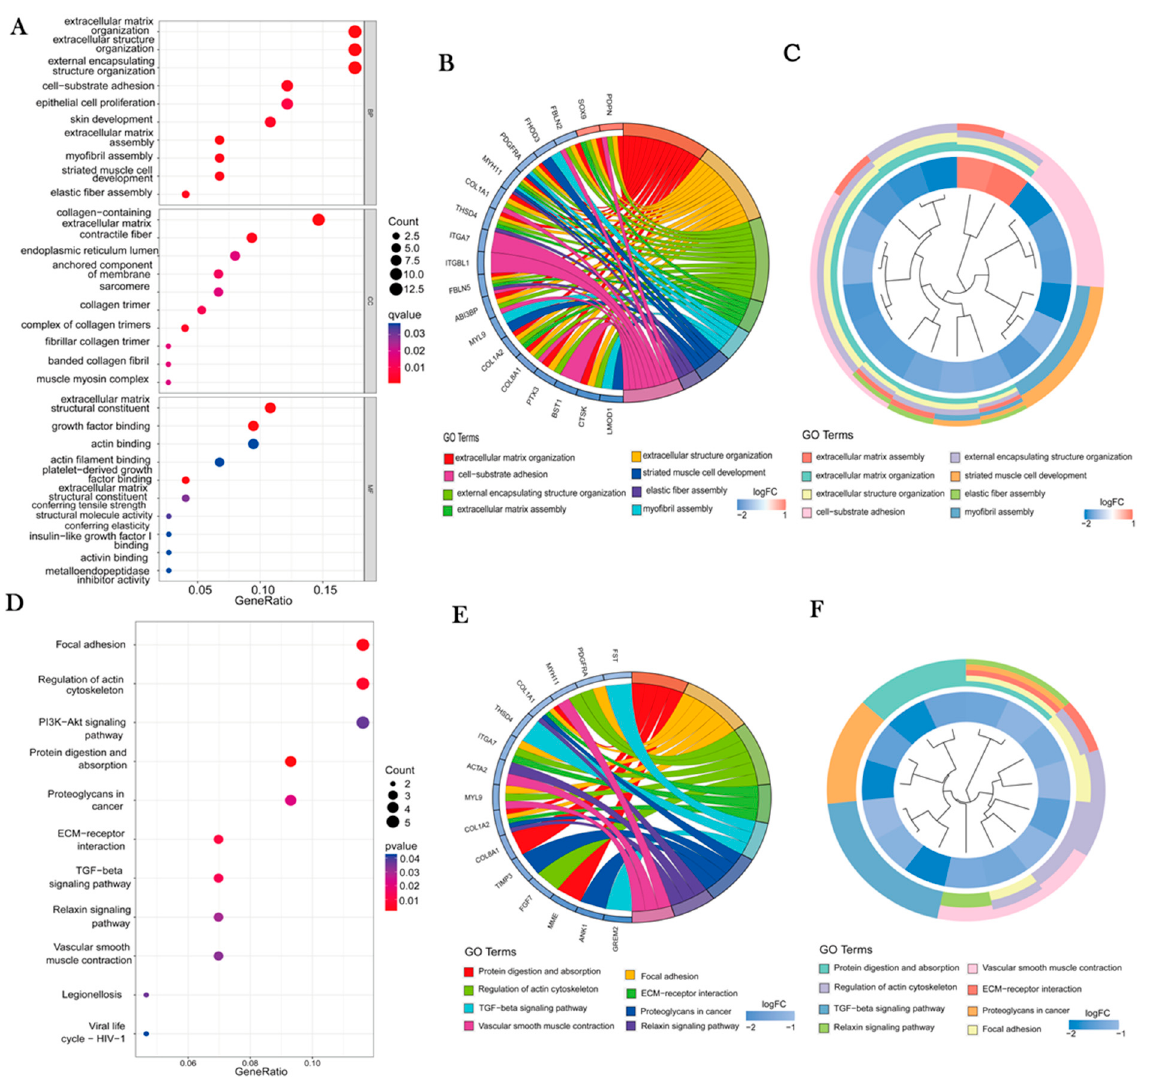
Figure 4. Graphs of GO and KEGG enrichment analysis results. ( A ) The results of the GO enrichment analysis of the top 10 GO terms of DFGs for BP, MF and CC are shown in three boxes with bubble plots. Gen-Ratio is on the x -axis, and log 10(adj P) values are on the y -axis. ( B/E ) GO/KEGG enrichment chord diagram. The left side indicates genes, red represents up-regulation, blue represents down-regulation, and color shades represent the number of fold changes. On the right, GO/KEGG terms are sorted by enrichment intensity change. ( C/F ) Gene clustering diagram: inner circles indicate DEGs, red circles represent up-regulated genes, blue circles indicate down-regulated genes, and the outer circle represents GO/KEGG keywords. ( D ) KEGG enrichment analysis results of DFGs. The Rich Factor (the ratio of differential genes to the total number of classified genes) was used as the x -axis, and the y -axis was the information of each enriched classification, with the size of bubbles indicating the number of differential genes and the color representing the corresponding significance information.